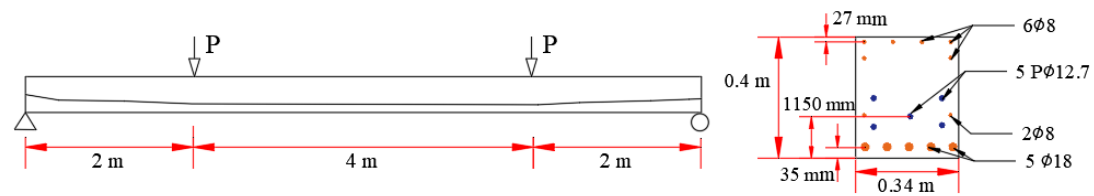
Figure 4. Longitudinal and cross-sectional view of the short-span prestressed concrete (PSC) beam.